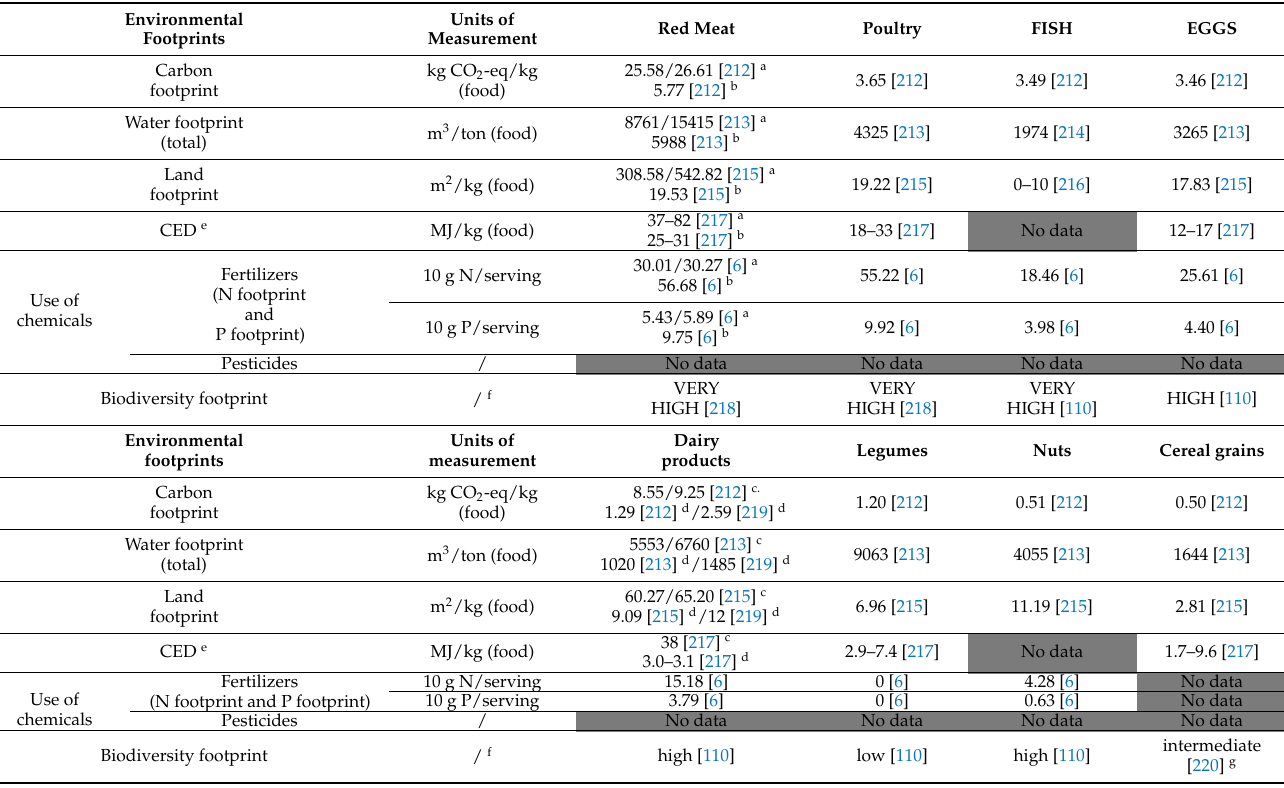
Table 11. Environmental footprints of various protein